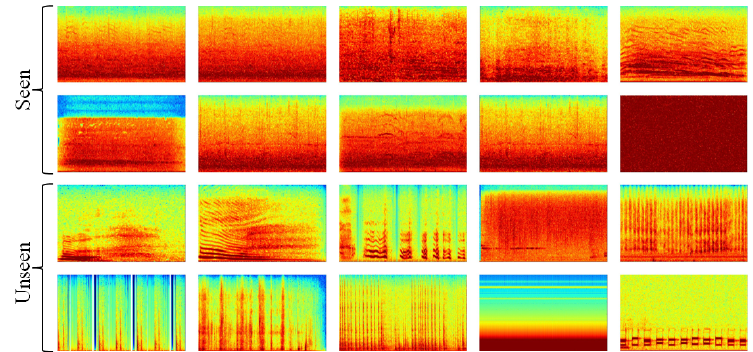
Figure 3. Spectrograms of the noise environments used in the testing process.